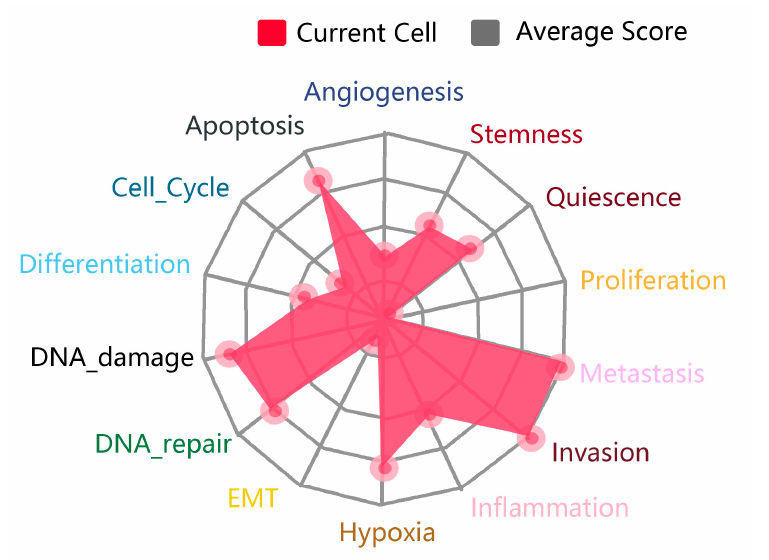
Figure 2. Pathophysiological processes associated with the presence of lncRNA in lung adenocarci-